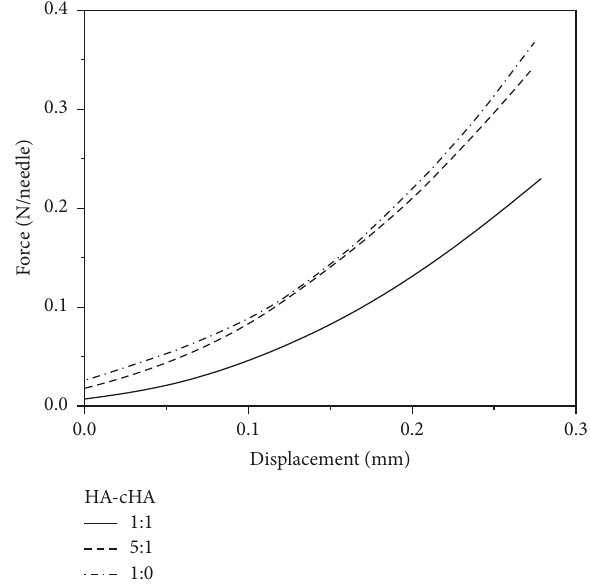
Figure 2: Axial mechanical strength of HA_CHA microneedles with different